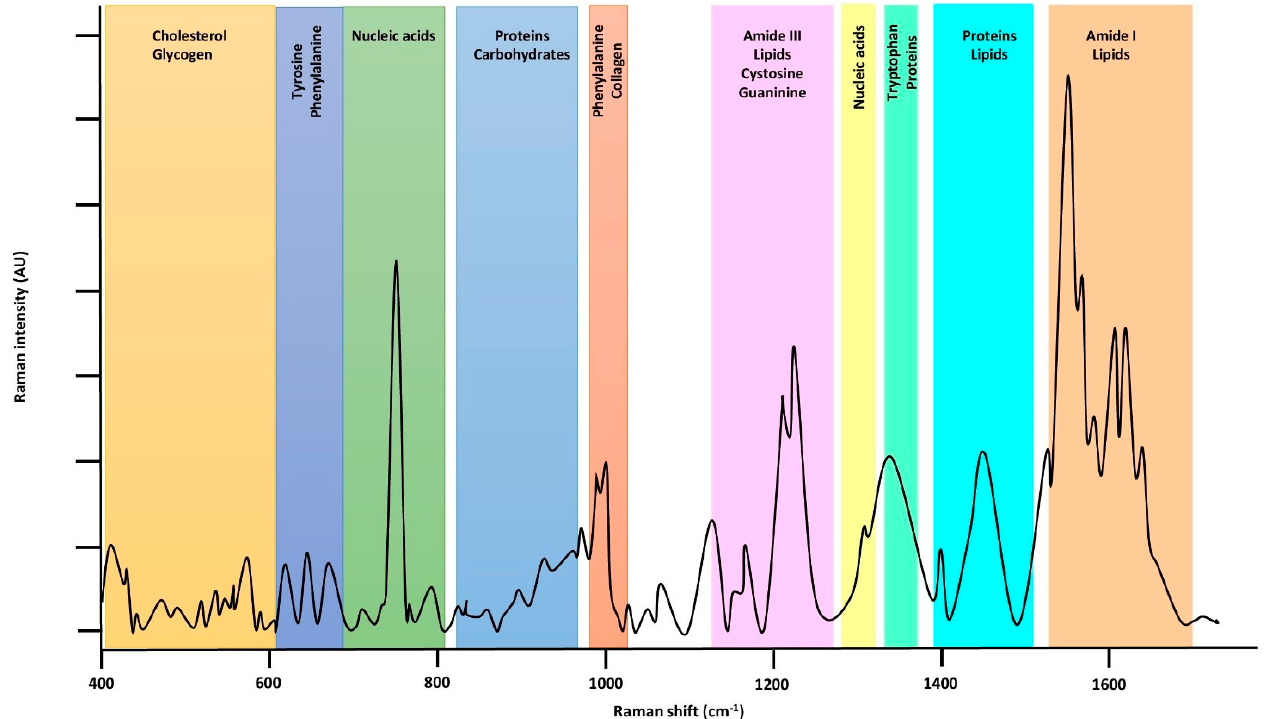
Figure 2. A typical biological Raman spectrum.